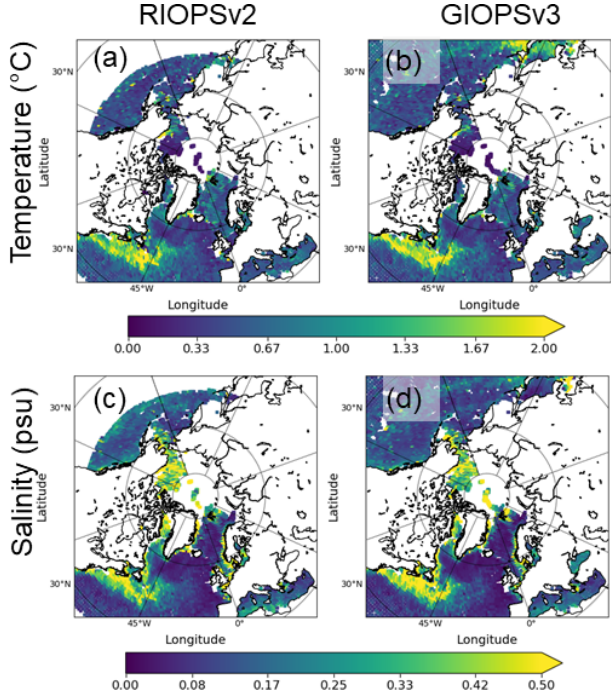
Figure 8. Innovation (observation–model) statistics of sea surface temperature for the period 1 January 2016 to 31 December 2018. The rms (a, b) and mean differences (c, d) are shown for RI- OPSv2 (a, c) and GIOPSv3 (b, d) .